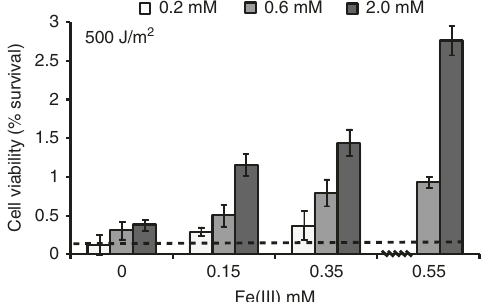
Fig. 2 Viability of UV-C irradiated Synechococcus cultures. Cultures grown at varying Fe(III) (0 mM, 0.15 mM, 0.35 mM, and 0.55 mM) and Si concentrations (white bar: 0.2 mM Si; light gray bar: 0.6 mM Si; dark gray bar: 2.0 mM Si) and irradiated with UV-C (254 nm) at 500 J/m 2 were assessed by colony forming units (CFU) counts. Cultures grown at 0.55 mM Fe(III) and 0.2 mM Si died (horizontal line). Viability was calculated for cultures grown in triplicate in three biological replicates. Error bars represent standard deviation at 2 σ uncertainty. Dashed line represents %